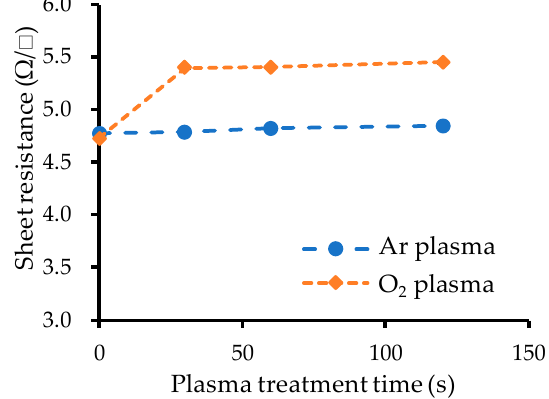
Figure 5. Measured sheet resistance vs. plasma treatment time.